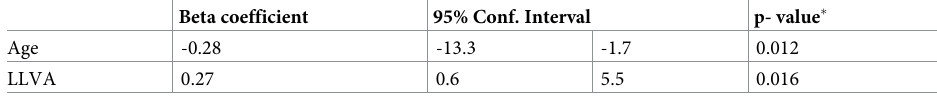
Table 3. Determinants of MVPA irrespective of AMD status.